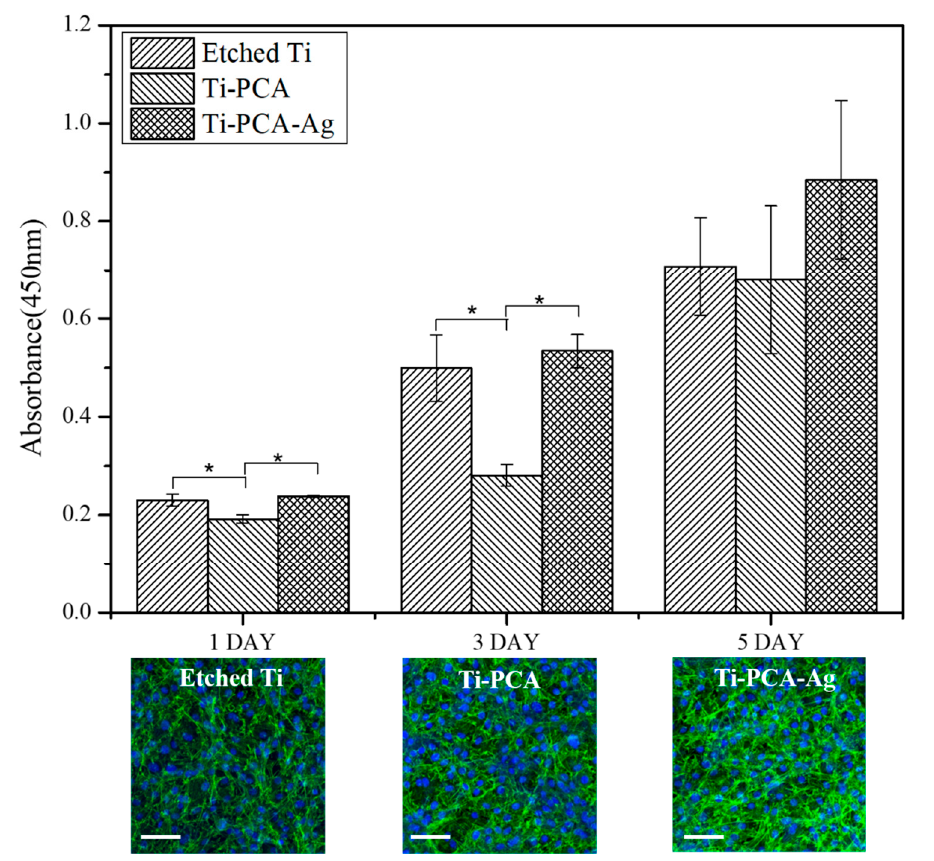
Figure 6. In vitro biocompatibility test using CCK-8 assay of MC-3T3 osteoblast cells. The data are reported as the mean ± standard deviation ( n = 3 and * indicates statistical significance ( p < 0.05) measured by one way ANOVA Tukey test) (inset: confocal images of MCT-3T3 cells after five days of incubation) (scale bar = 100 μ m).